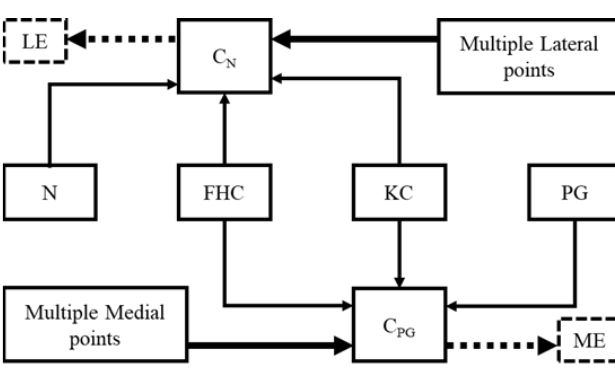
Figure 5. Working principle of the modified Whiteside’s